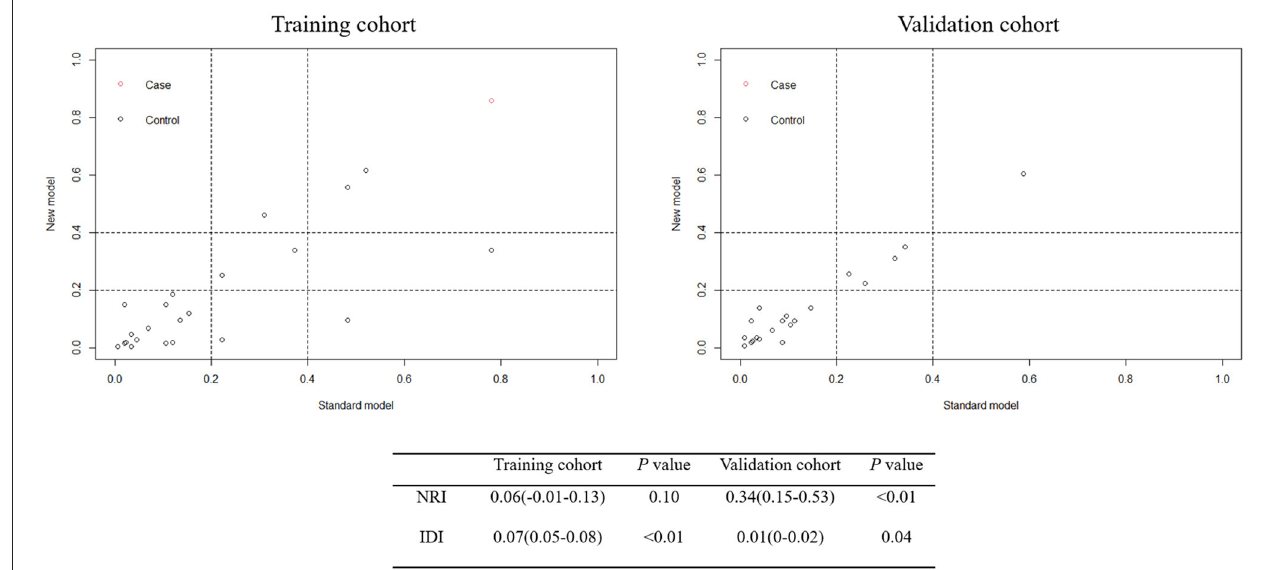
FIGURE 4 | Net Reclassification Index (NRI) and Integrated Discrimination Improvement (IDI) between model A and model B in the training and validation cohorts.